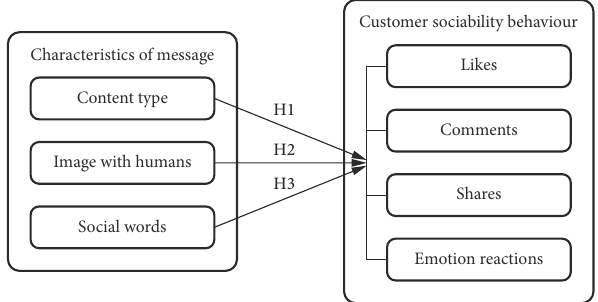
Figure 1. The hypothesised relationship between characteristics of a message and customer sociability behaviour outcomes on Facebook (source: own